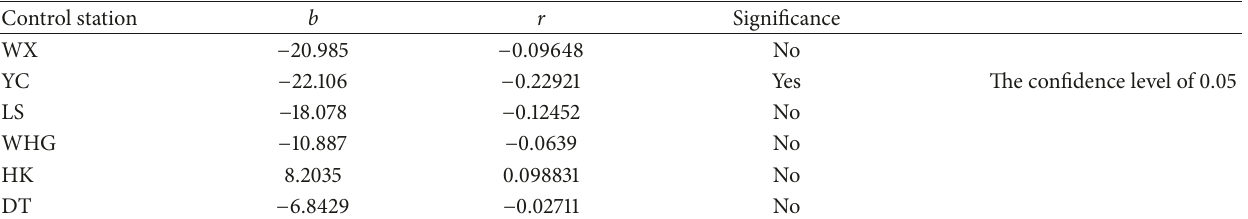
Table 3: The runoff linear 𝑡 propensity estimate table of the YRB. Control